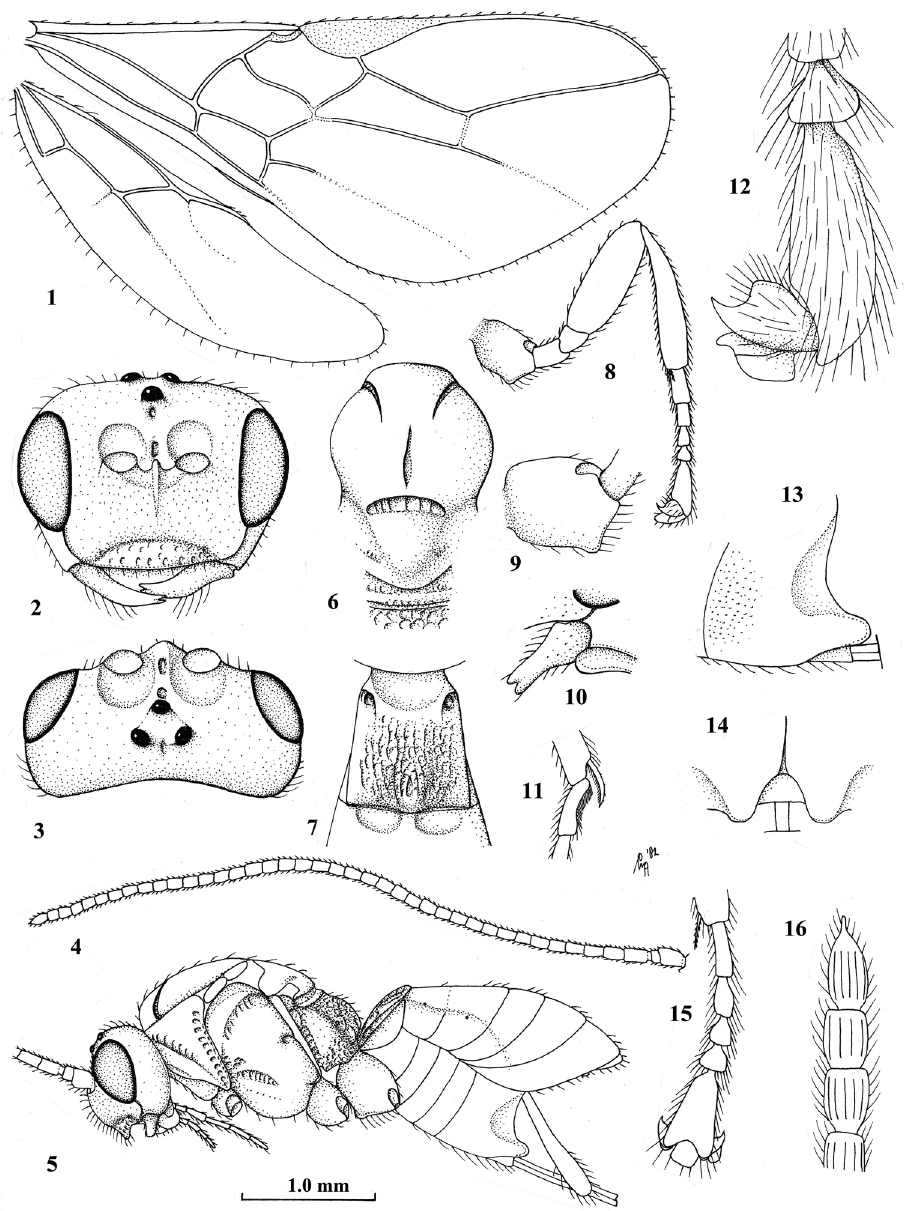
Figures 1–16. Nipponopius incisus Fischer, ♀ , holotype. 1 wings 2 head anterior 3 head dorsal 4 an- tenna 5 habitus lateral 6 mesosoma dorsal 7 first metasomal tergite dorsal 8 hind leg lateral 9 hind coxa lateral 10 mandible and occipital carina latero-ventral 11 fore tibial spur 12 outer hind claw lateral 13 hy- popygium lateral 14 hypopygium ventral 15 hind tarsus dorsal 16 apical segments of